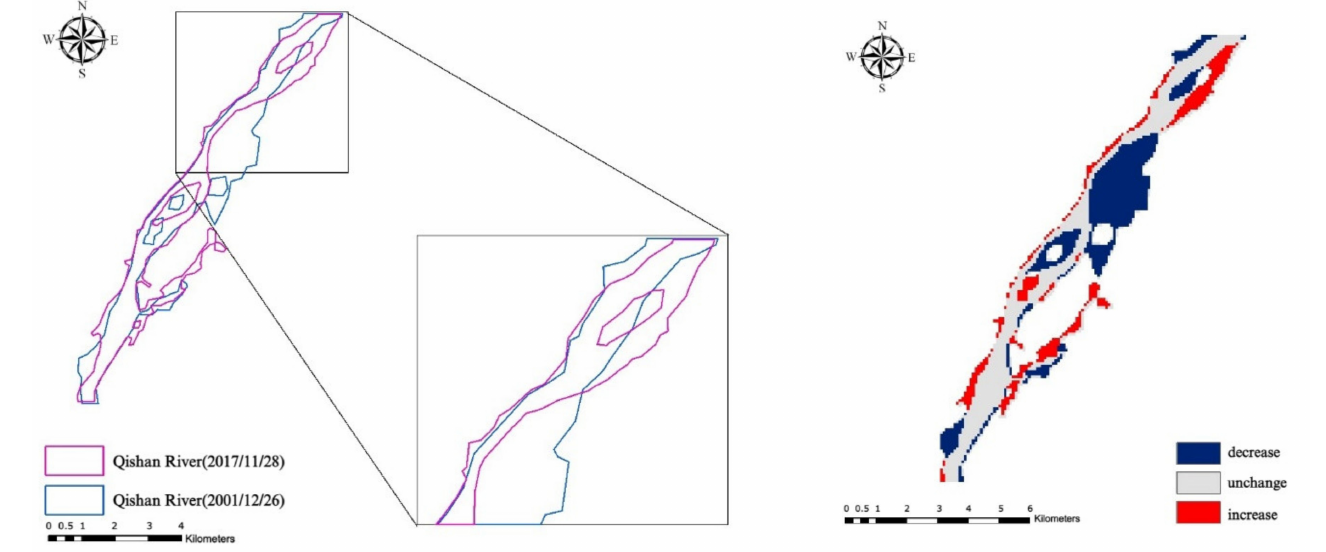
Figure 12. The Qishan River changes between two epochs. For the Xiuguluan River, using NDWI and mathematic morphology had the best performance in extracting the water bodies of the two epochs. The difference between the two epochs is shown in Figure